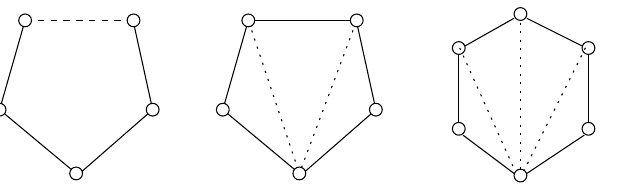
Figure 3. The forbidden subgraphs of DH ( 1 ) expressed according to the notion of chord distance. Dashed lines represent paths of length at least one. Dotted lines represent chords that may or may not